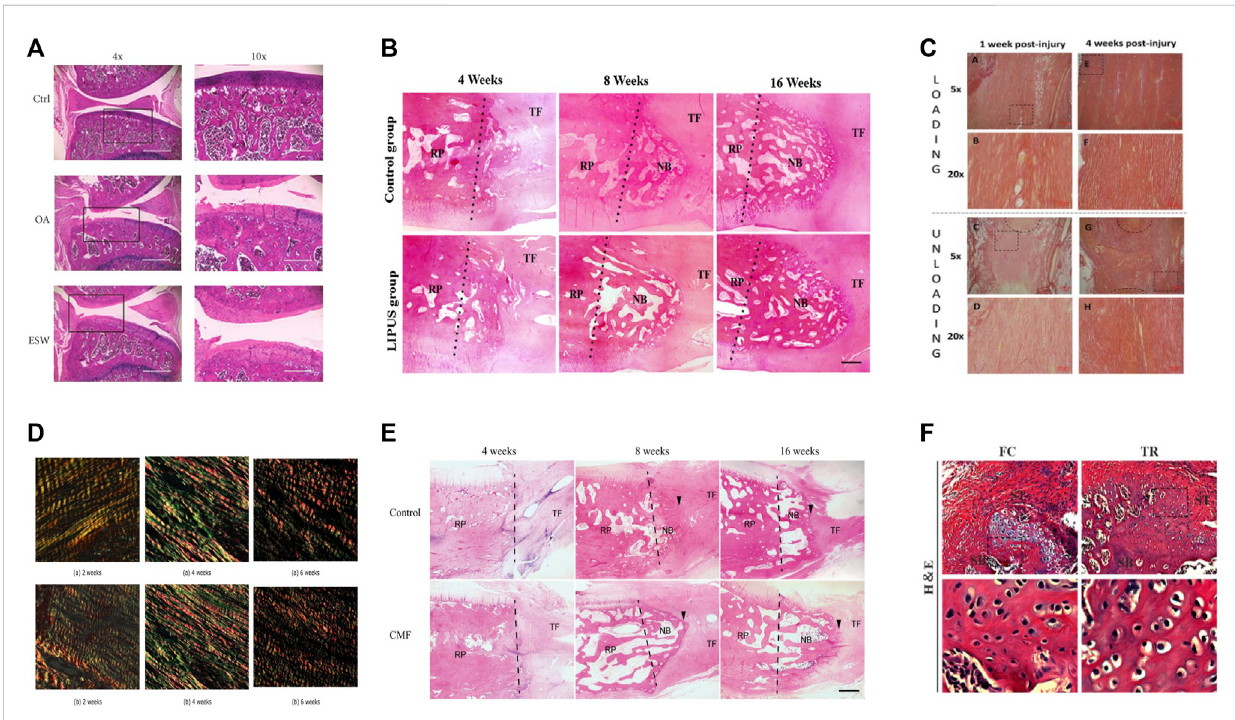
FIGURE 2 The typical histological or photograph images before and after treatment of each method. (A) Before and after ESWT with improved pathology. Reproduced with permission (Yu et al., 2017); (B) Comparative histology before and after LIPUS treatment. New bone formation at the proximal patella was observed in both groups at postoperative weeks 8 and 16. The LIPUS group showed more trabecular and marrow cavities than the control group at postoperative week 16. The dotted line represents the surface of osteotomy (NB, newly formed bone; RP, remaining patella; TF, tendon fi ber). Reproduced with permission (Lu et al., 2016); (C) Before and after comparison chart of mechanical loading treatment. Adipocyte were seen within the callus tissue in both groups at 1 week, but it was more common in the loaded tendons, at 4 weeks, there was less adipocytes in thecallus in both